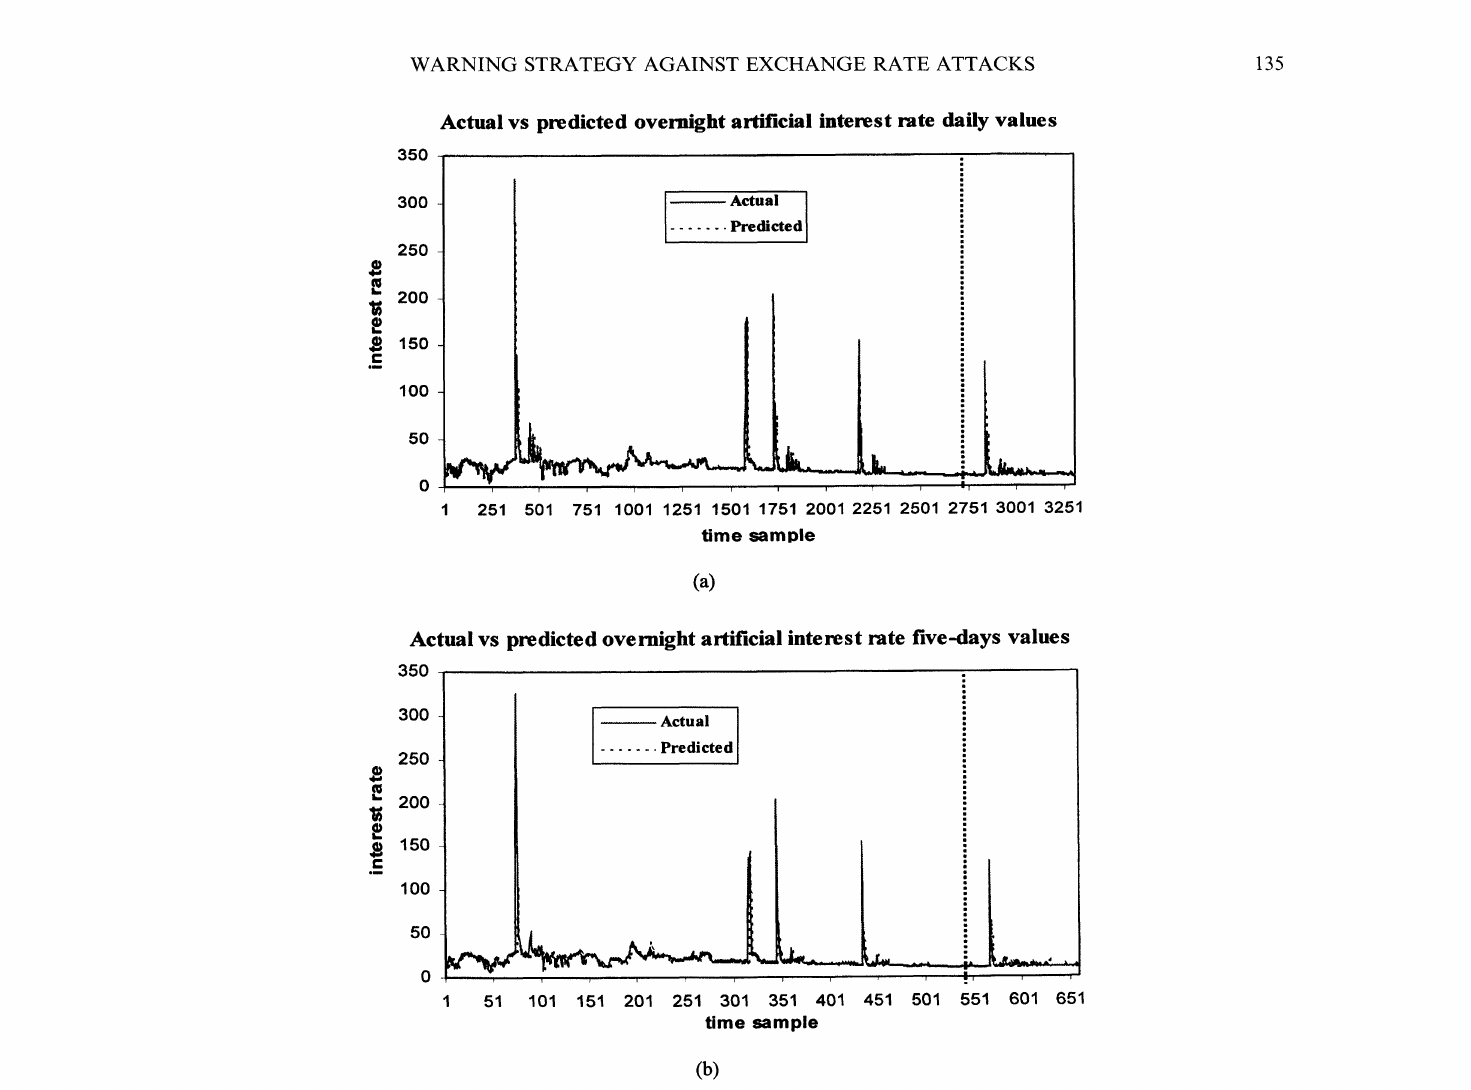
FIGURE 6 Actual versus predicted interest rate values produced with the MLMAP algorithm using artificial series on a (a) daily and (b) 5-days prediction horizon. fluctuation prediction ranges on the